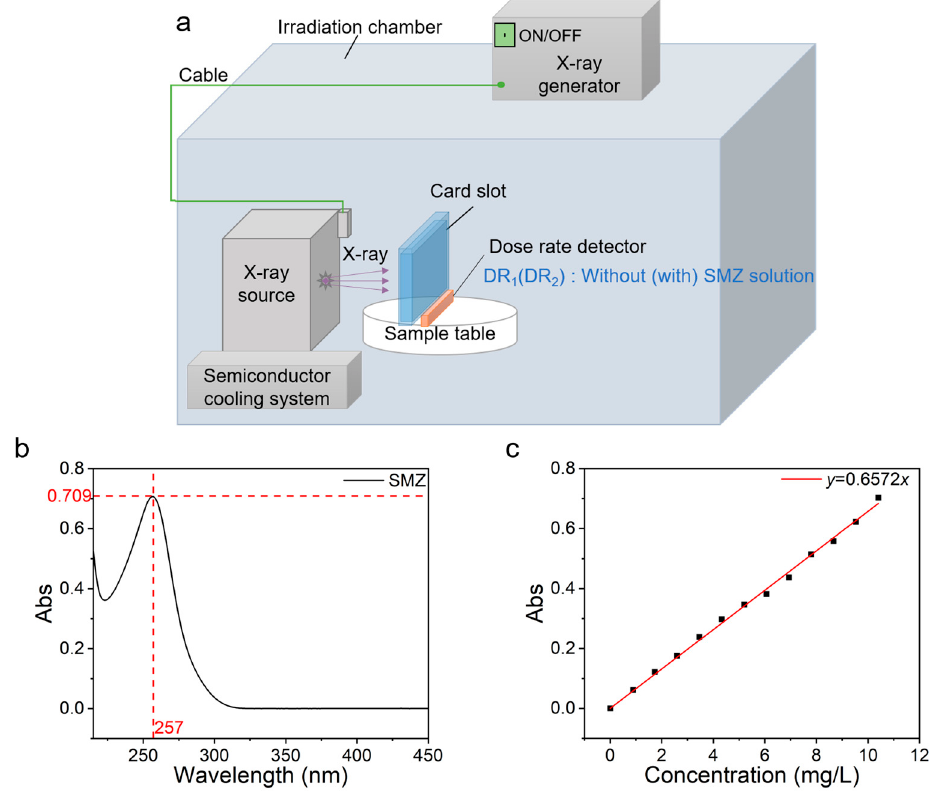
Figure 1. Irradiation and concentration calibration of SMZ solutions. ( a ) Schematic drawing of a low-energy X-ray irradiation device; ( b ) ultraviolet spectrogram of SMZ; ( c ) relationship between Abs and SMZ concentration.